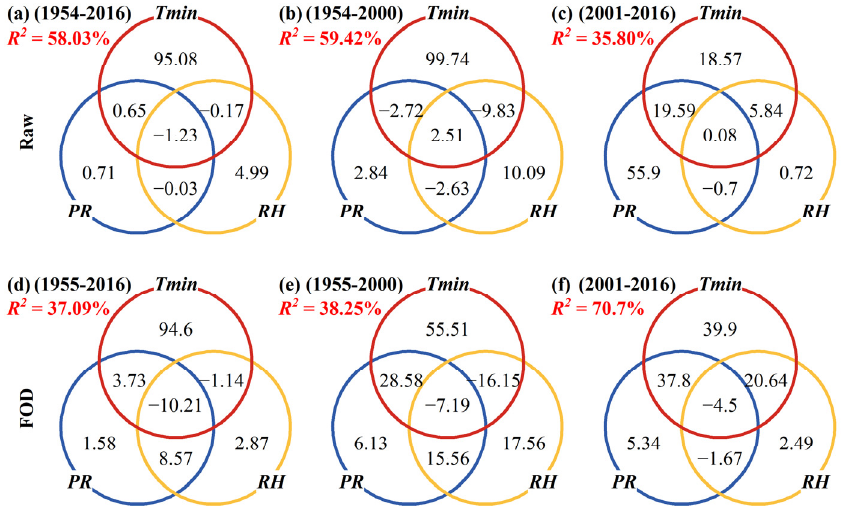
Figure 5. The proportion of contribution (%, the numbers inside the Venn diagram) of Tmin , PR and RH in explaining the variance of TRW at different periods by using commonality analysis. ( a – c ): Raw data; ( d – f) : First-order difference (FOD). R 2 is the variance of TRW explained by Tmin , PR and RH